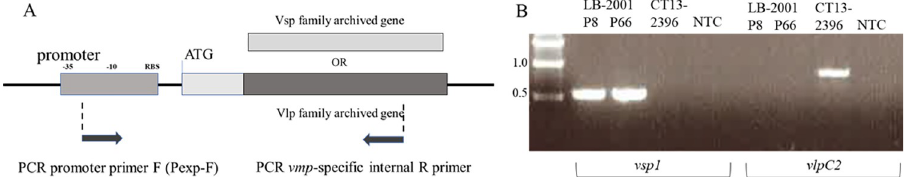
Fig 1. PCR of the expression locus. A) Illustration of the expression site with the active promoter consisting of the consensus ribosome binding site (RBS) and the -10 and -35 elements. ATG is the start codon of the coding sequence for the expressed Vmp, either a Vsp or a Vlp. The promoter specific forward primer (Pexp-F) is paired with a Vsp or Vlp specific internal reverse primer to amplify the gene being expressed for identification by amplicon sequencing. B) PCR amplification results of the vsp1 and vlpC2 genes in the expression site for strain LB-2001 low passage (P8) and high passage (P66), and low passage strain CT13-2396. NTC = no template control. M = molecular size markers that are denoted on left of